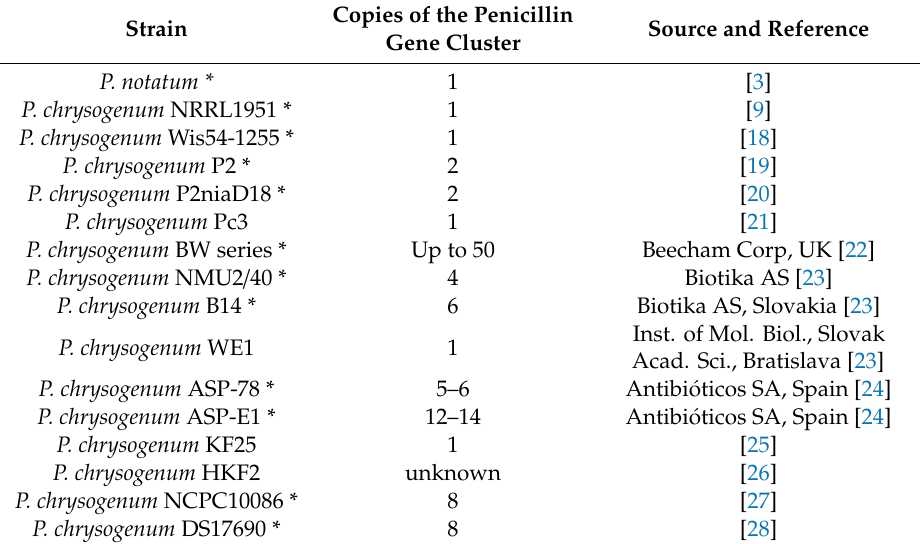
Table 1. Penicillium chrysogenum strains studied by di ff erent research